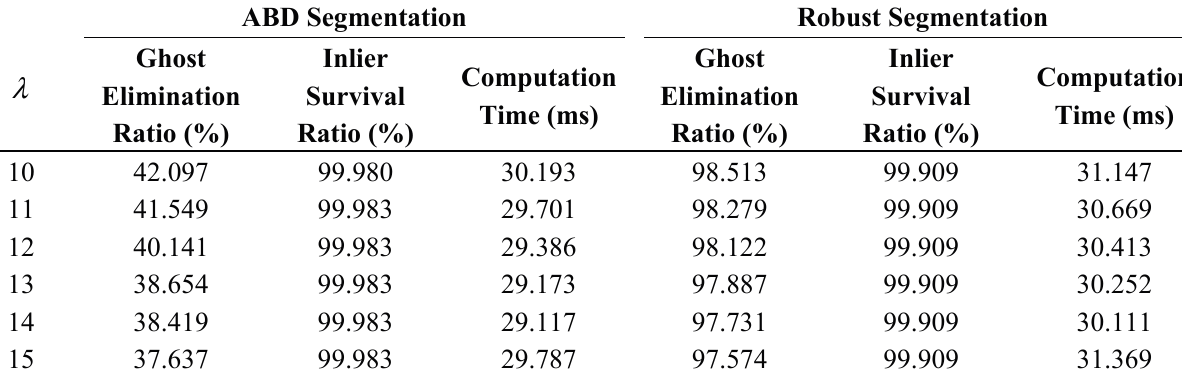
Table 5. Results of ghost elimination for flat road. ABD Segmentation Robust